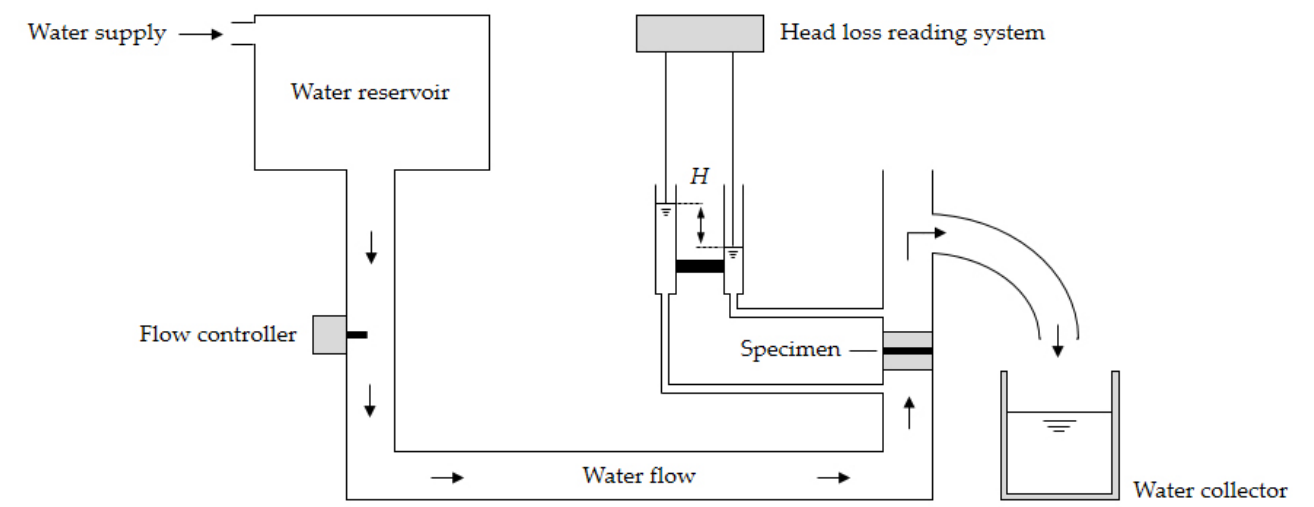
Figure 2. Schematic representation of the equipment used in the water permeability normal to the plane tests (the water course is indicated by arrows).